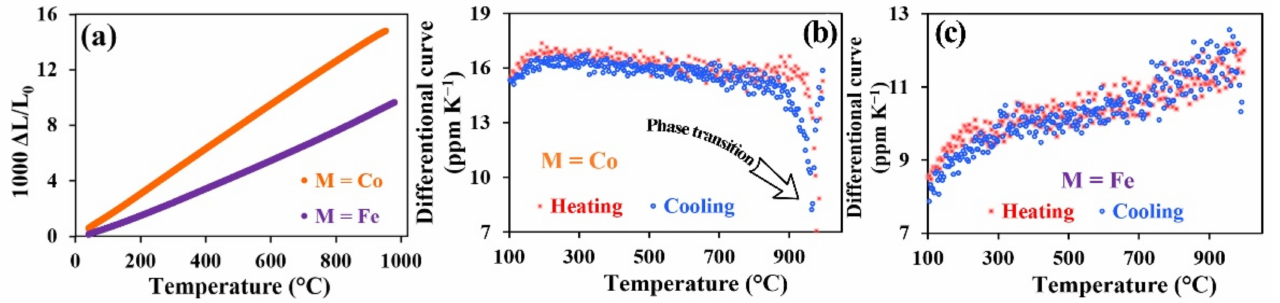
Figure 4. Dilatometry data of the ceramic PrNi 0.4 M 0.6 O 3– δ samples: temperature dependence of linear expansion at the cooling ( a ) and differential TEC values ( b , c ) obtained at the heating and